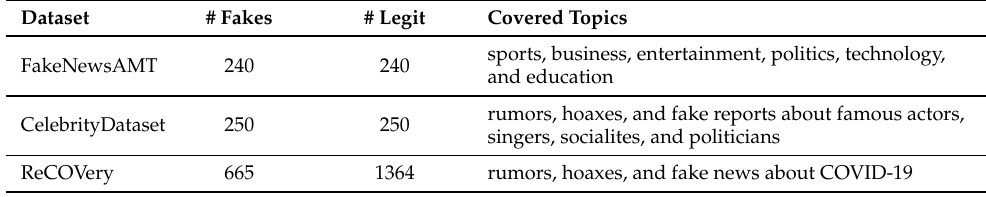
Table 4. Statistics of the datasets that were used to test fake news classification with the proposed Multiverse